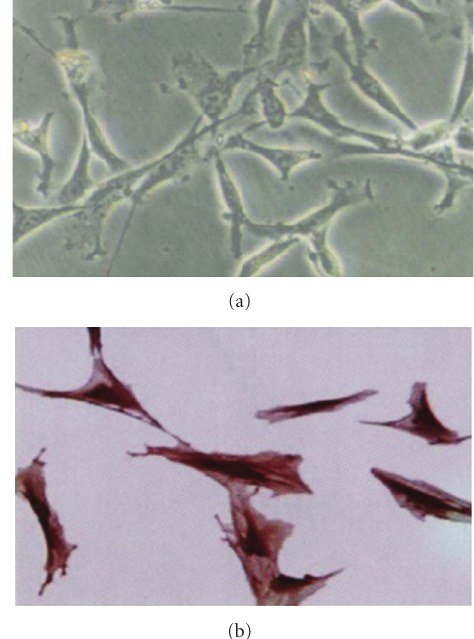
Figure 1: The analysis of cultured VSMCs in morphology and identification. (a) The morphology of cultured VSMCs detected by phase-contrast microscope. Magnification of light microscopy images is × 100. (b) SM- α actin immunocytochemical staining of cultured VSMCs. Magnification of light microscopy images is × 400.